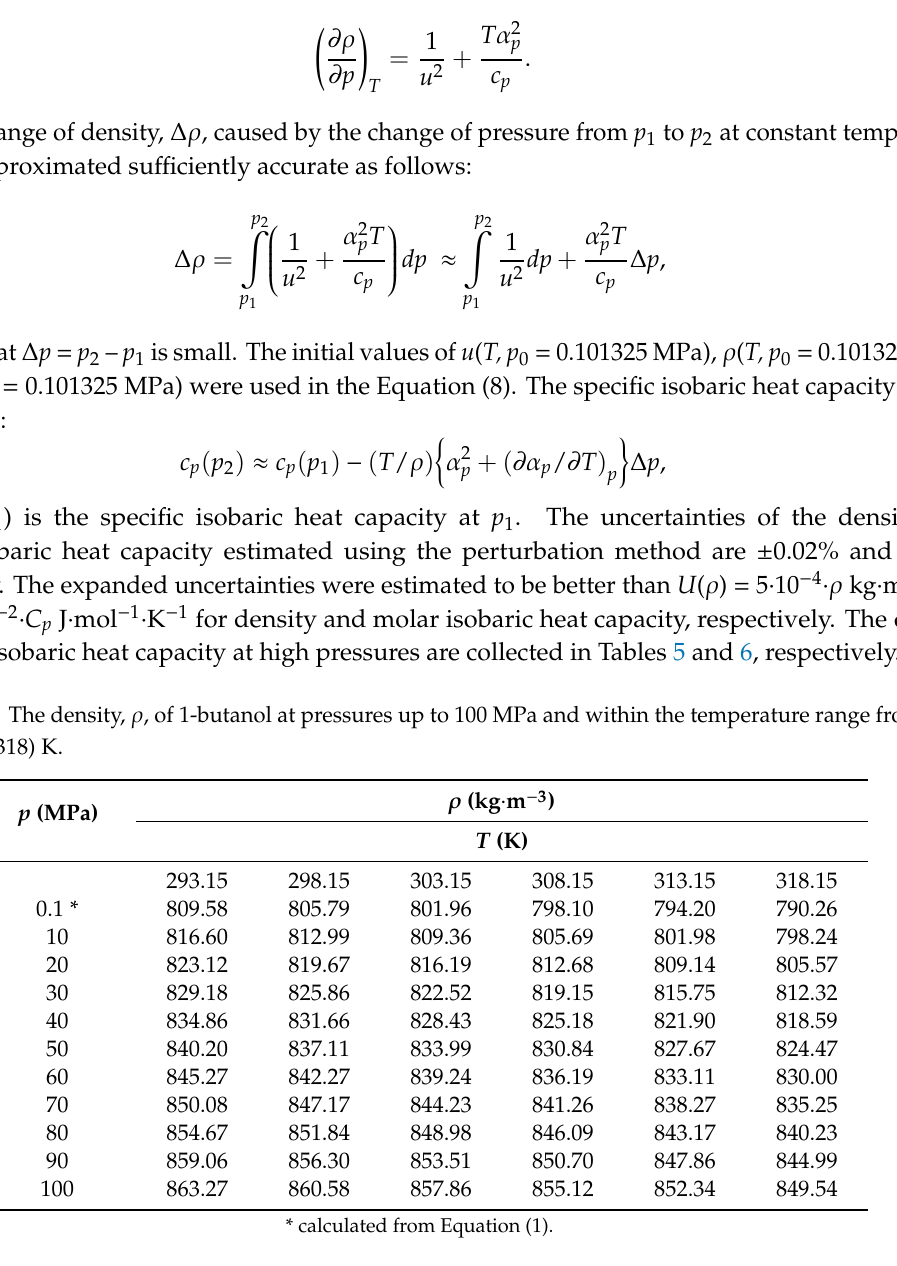
Table 6. The isobaric molar heat capacity, C p , of 1-butanol at pressures up to 100 MPa and within the temperature range from (293 to 318)